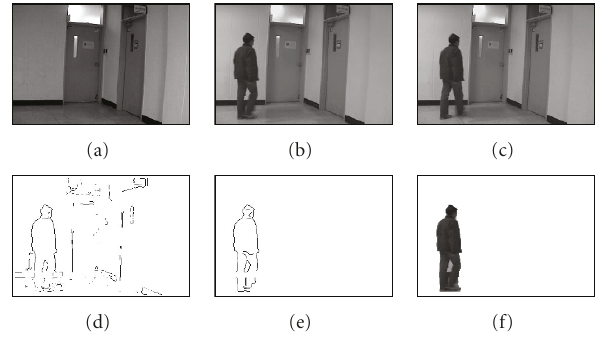
Figure 9: Performance with the change of illumination. (a) Background; (b) I 52 ; (c) I 53 ; (d) detected moving edges of I 53 by KW ; (e) detected moving edges of I 53 by the proposed method; (f) segmented moving object by the proposed